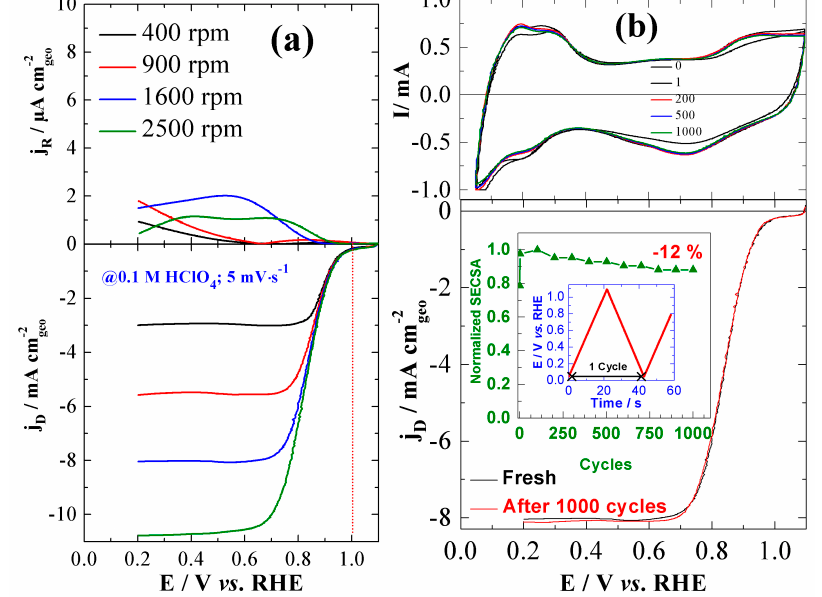
Figure 12. ORR polarization curves recorded in a O 2 -saturated 0.1 M HClO 4 solution at 20 wt% Pt/C catalyst prepared from the BAE method: ( a ) Ring (top) and disc (bottom) current density; ( b ) Electrochemical durability (top) and the ORR polarization after 1000 CVs (bottom). ORR performed at 5 mV s −1 , 1600 rpm, and room temperature. Insets show the SECSA decay over the 1000 cycles from 0.05–1.1 V vs. RHE at 50 mV s −1 . Metal loading on the electrode: 100 µg Pt cm − 2